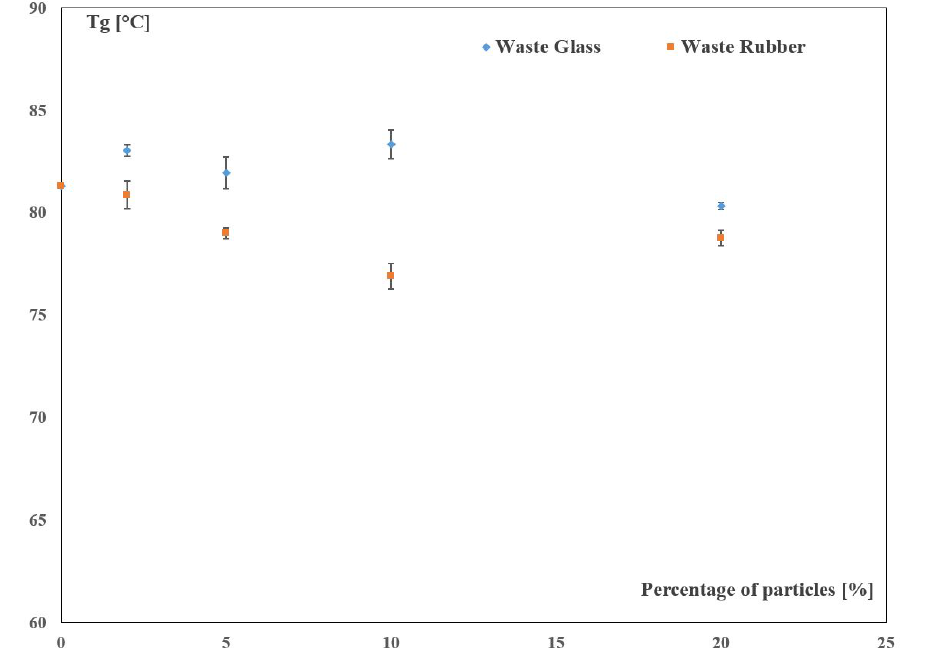
Figure 5. Trend of the Tg values of both types of blends in function of the percentage of particles. The dynamic complex modulus of the composites at the temperature of 30 ◦ C is reported in function of the waste particles percentage in Figure 6. For the composites with waste glass additives, the linear upward trend is evident, reaching approximately 4.5 GPa for W.G. 20%. By contrast, a downward trend characterized the waste rubber composites where the complex modulus was about 1.60 GPa at the maximum particles content